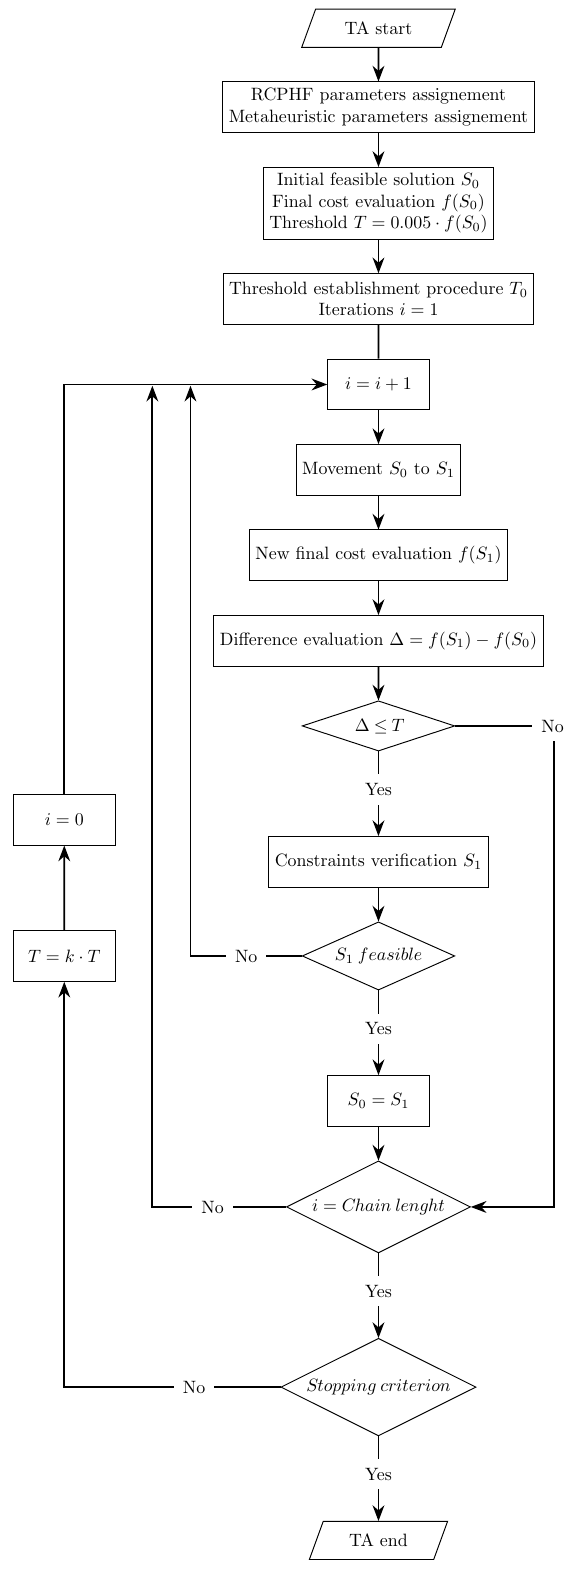
Figure 5. Flowchart of the threshold accepting (TA)